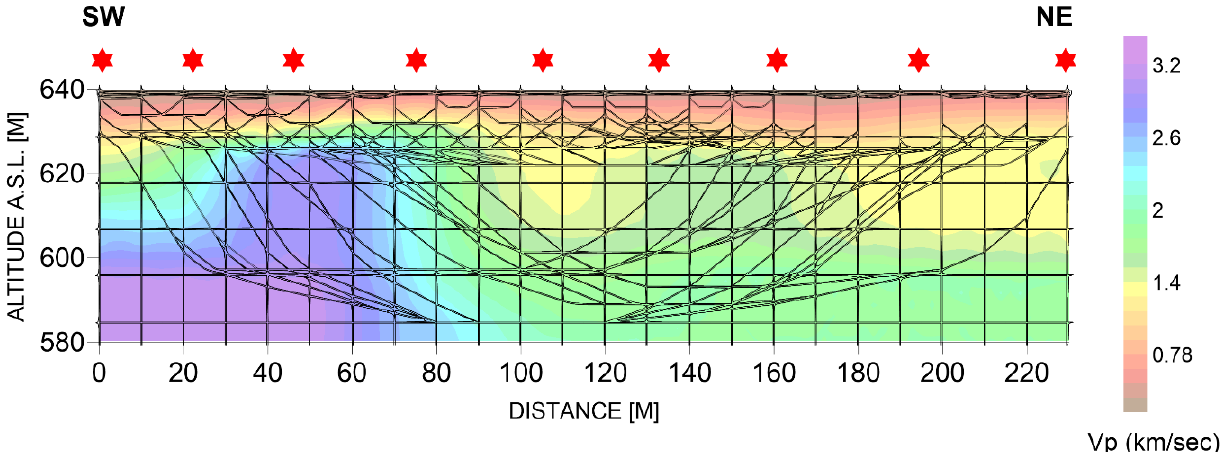
Figure 6. Results of the seismic tomography at the “Il Lago” Plain (profile Seis_1, Figure 3), with raytracing overlaid; the red stars are the shot positions.